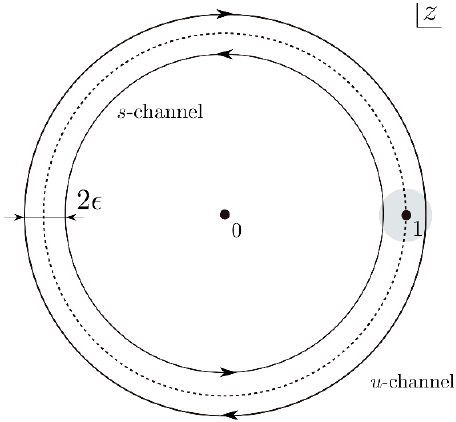
Figure 1 . The cross ratio z -plane. The region j z j < 1 is described by the s -channel OPE in the large Q limit, whereas the region j z j > 1 is described by the u -channel OPE. We consider the integral of the derivatives of the correlation function along the drawn contours, namely we take the di(cid:11)erence between the derivative evaluated slightly outside and slightly inside the circle. The smoothness of the correlator away from z = 1 implies that the di(cid:11)erence in that region is of O ( (cid:15) ). On the other hand, we can use the OPE to see that the result should be O (1). This means that the integral is controlled by the singularity close to z = 1. In this region the correlator is governed by its properties in the macroscopic limit. The shaded area denotes the short distance region relevant for this